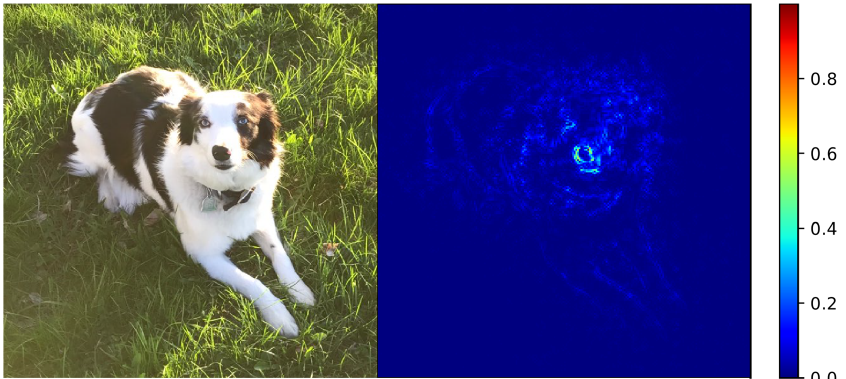
Figure 5. Sensitivity analysis applied to an image of a dog. For the heat map (attention map) on the right the color bar quantifies the gradient of each pixel with respect to how likely the neural network considers this image to be of a dog. This highlights the pixels that the neural network considered to be the most important for the classification of the picture. The pixels that correspond to the outline of the dog are seen to be the most important for the classification and thus have the highest